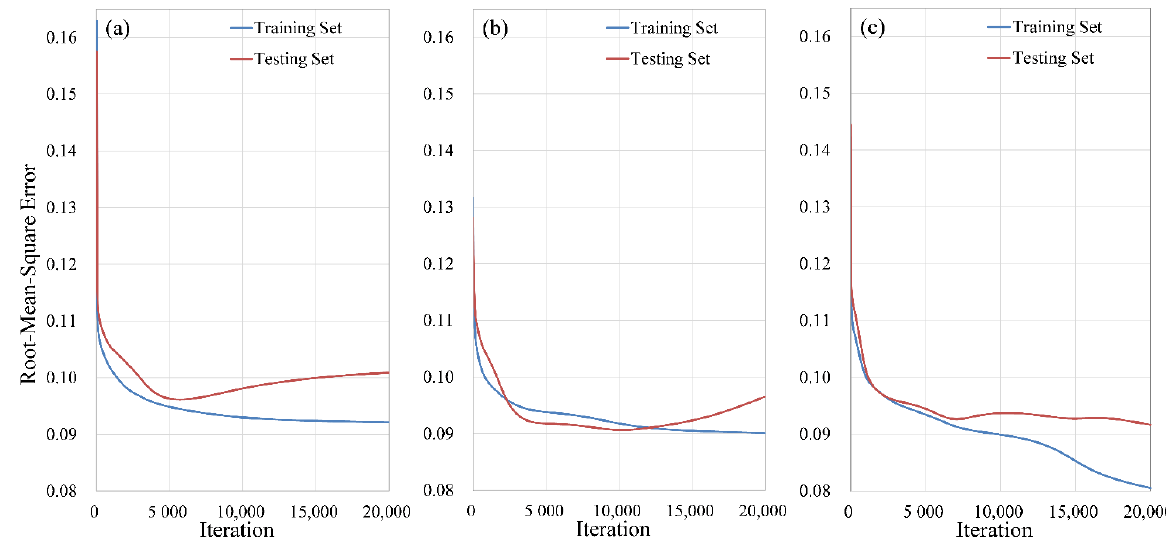
Figure 2. The result of the training: ( a ) 3 neurons in the hidden layer, ( b ) 7 neurons in the hidden layer, ( c ) 12 neurons in the hidden layer.